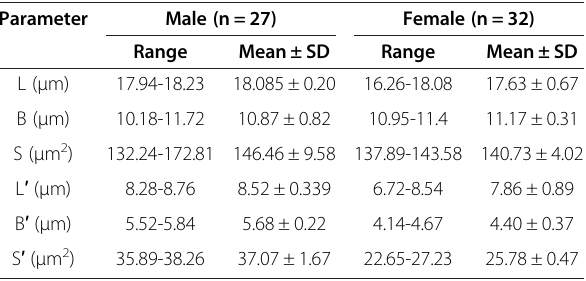
Table 1 Average length and breadth of the erythrocytes (LB), nuclei (L ′ B ′ ), surface area of erythrocyte (S) and nuclei (S ′ ) in male (n = 27) and female (n = 32) Naja naja snakes (p < 0.05)